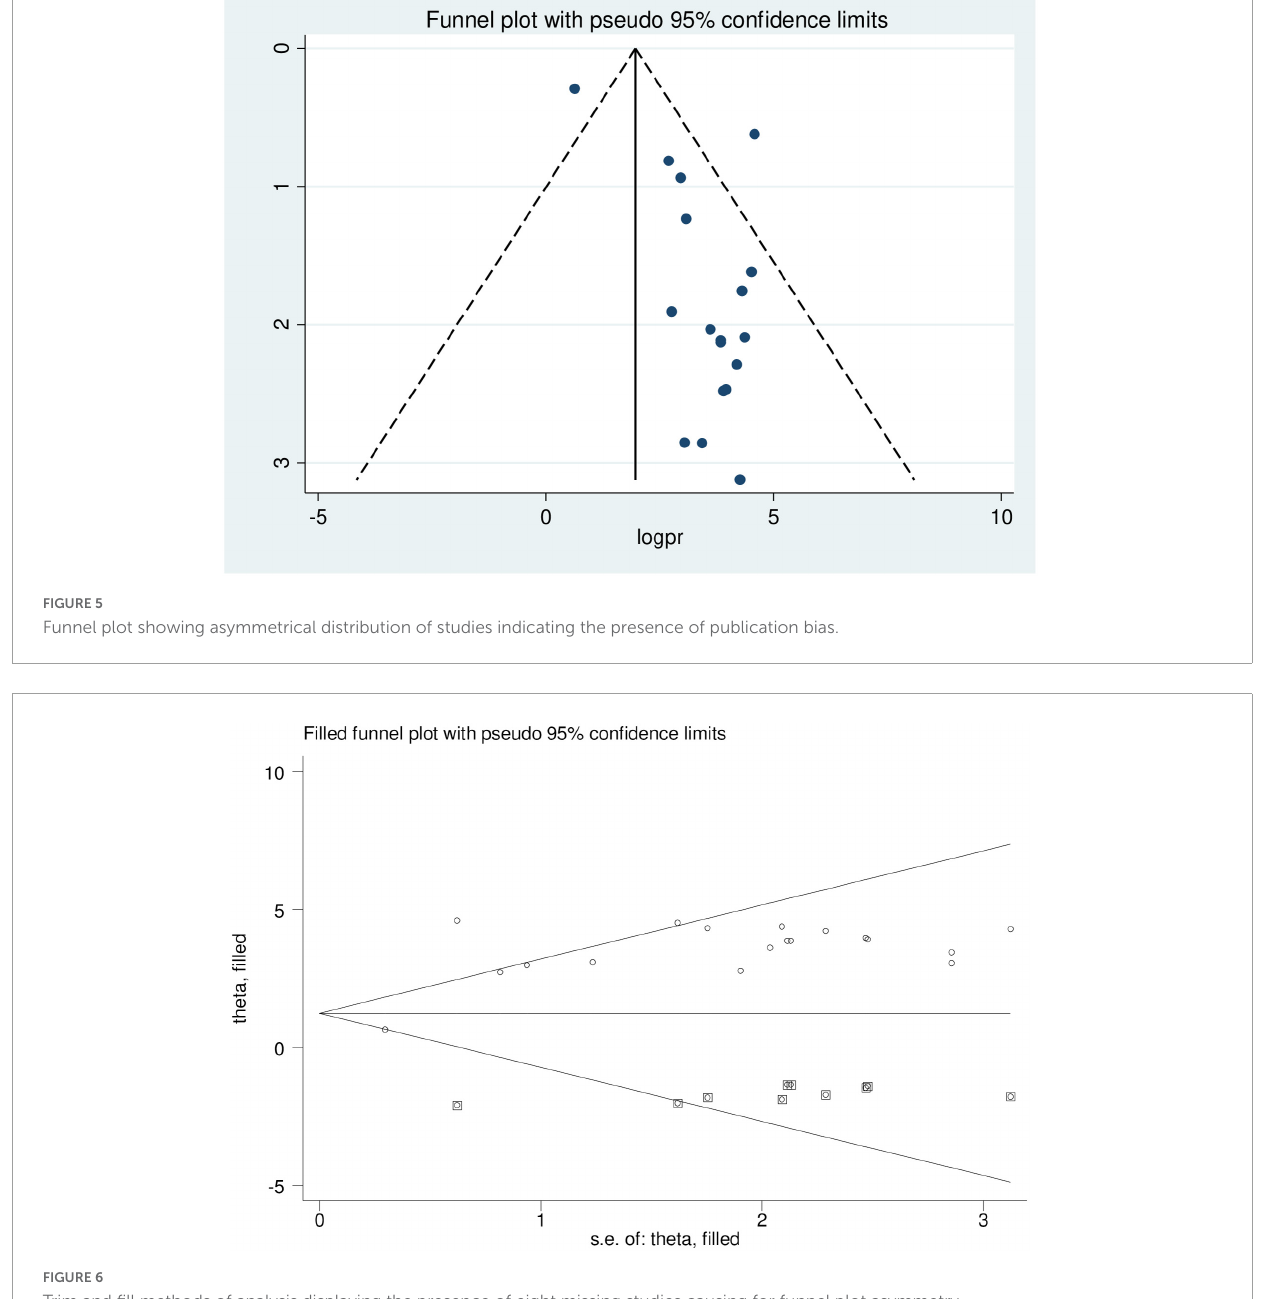
of the existence of heterogeneity between studies (I 2 = 57.3%) ( Figure 8